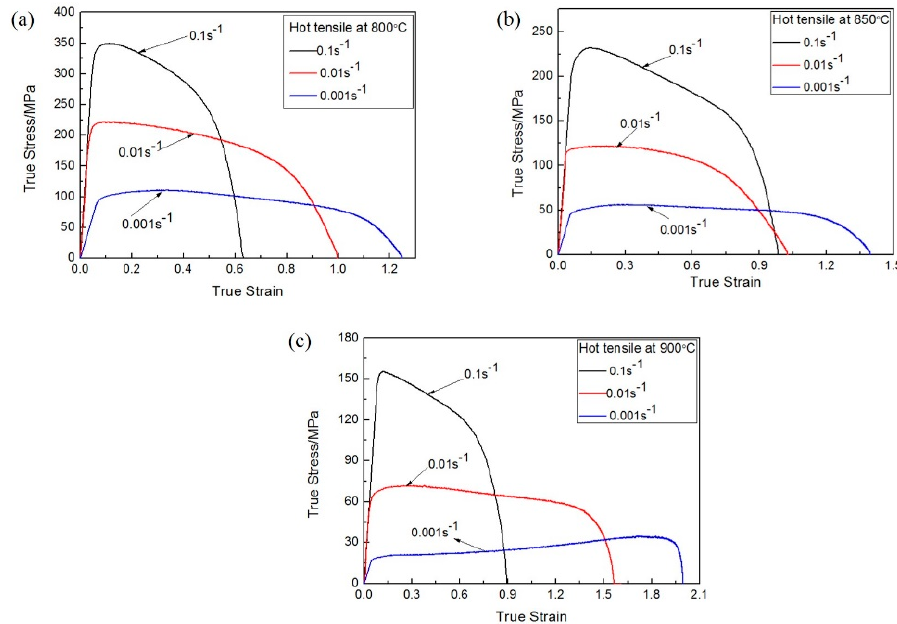
Figure 3. Flow stress-strain curves of the high-temperature tensile tests at: ( a ) 800 °C, ( b ) 850 °C, ( c ) 900 °C.